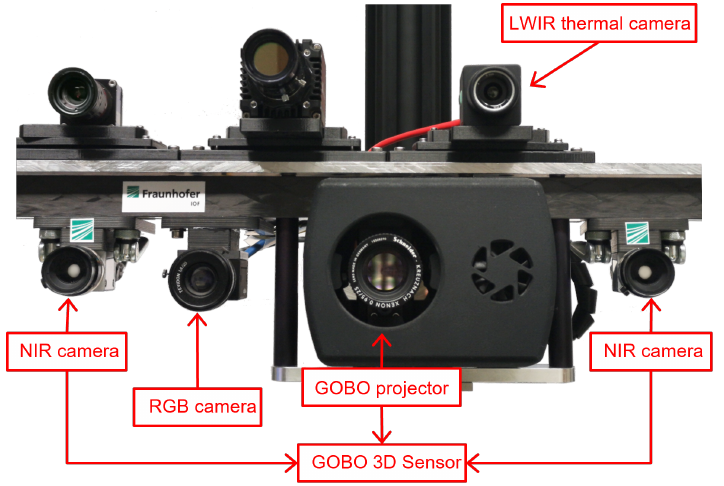
Figure 2. A multimodal 3D sensor system consisting of an active stereovision 3D sensor based on GOBO projection, an RGB camera (FLIR Grasshopper3), and a thermal camera (FLIR